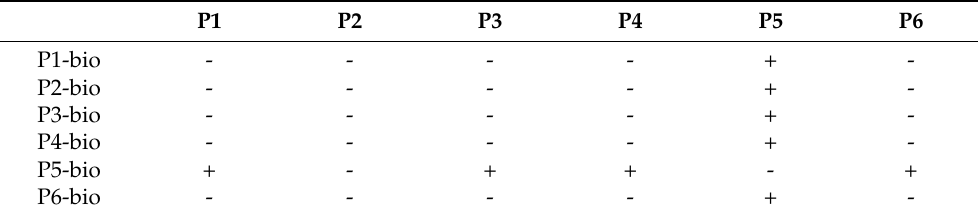
Table 1. Screening of paired